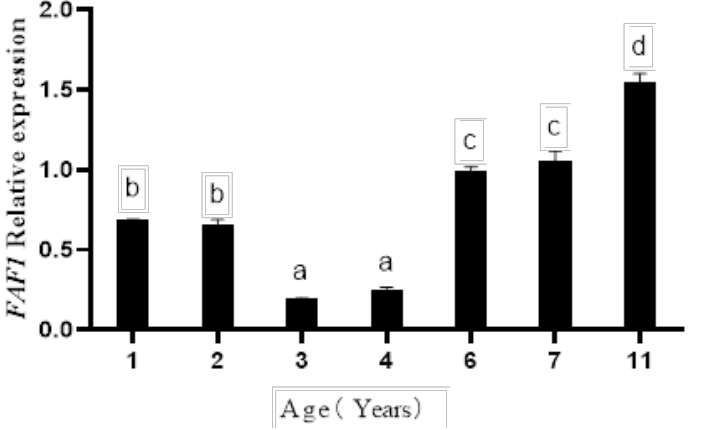
Figure 3. Relative expression levels of FAF1 protein in testis at different ages (different letters indicate significantly different values at p < 0.05).